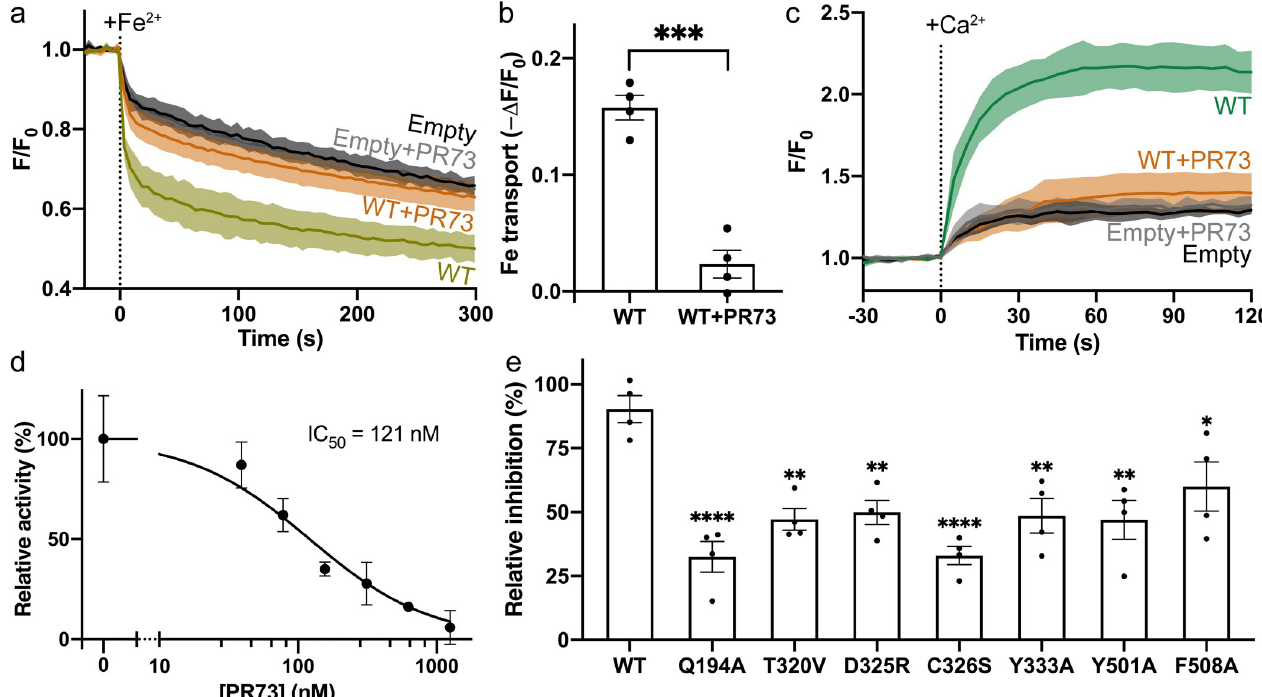
Fig 7. Inhibition of Fe 2+ and Ca 2+ transport by PR73. ( a ) Time-dependent Fe 2+ uptake by HEK cells expressing WT Fpn. Approximately 100 μ M Fe 2+ (stabilized by 1 mM ascorbic acid) was administered at time zero. ( b ) Fpn-specific Fe 2+ transport from data in ( a ). Each bar represents the change in fluorescence in WT after subtraction of that in empty vector control. Unpaired Student’s t test, p < 0.005. ( c ) Time-dependent Ca 2+ uptake by HEK cells with or without HsFpn. Approximately 500 μ M of Ca 2+ was administered at time zero. The presence of 2 μ M PR73 inhibits the transport. ( d ) Inhibition of Ca 2+ transport by Fpn at different concentrations of PR73. ( e ) Relative inhibition of PR73 against HsFpn mutants. Dunnett’s test was used as a post hoc test following one-way analysis of variance with the WT as control. In ( a ) and ( c ), the solid lines represent the mean ( n = 4) and the shaded areas the SD. In ( b ), ( d ), and ( e ), data are plotted as means with error bars representing the SEM. The solid black line in ( d ) is the fit of data to a single-binding site inhibition equation. Statistical significances are indicated: � , p < 0.05; �� , p < 0.01; ��� , p < 0.005; ���� , p < 0.001. Source data for ( a – e )can be found in S1 Data . HEK, human embryonic kidney; SEM, standard error of the mean; SD, standard deviation; WT, wild type.